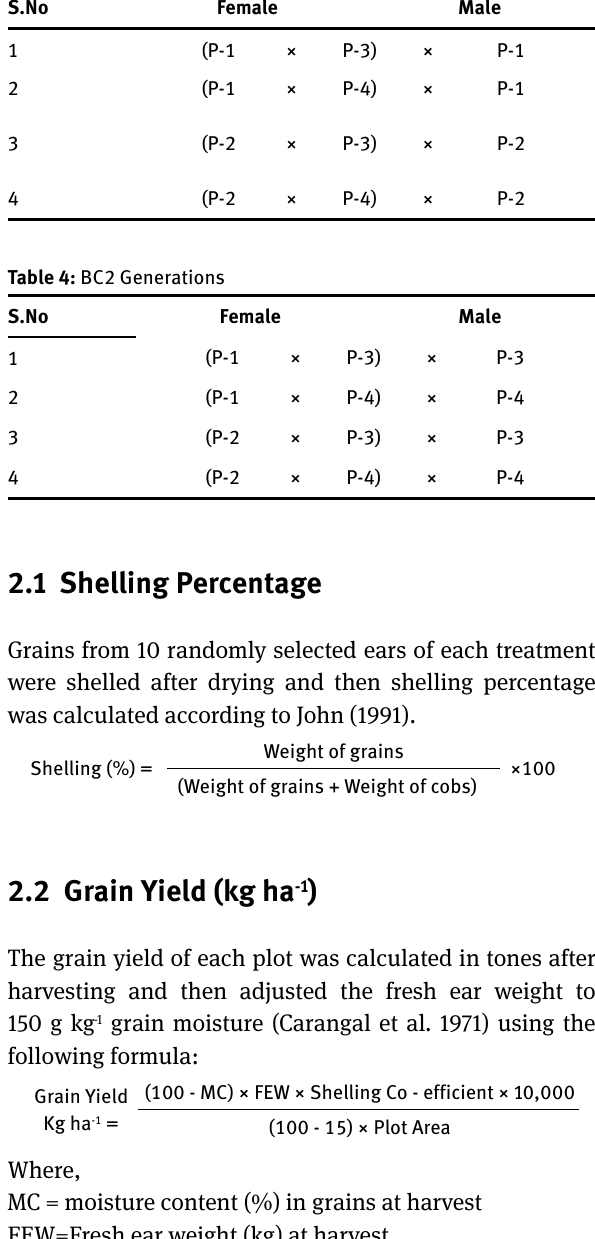
Table 3: BC1 Generations S.No